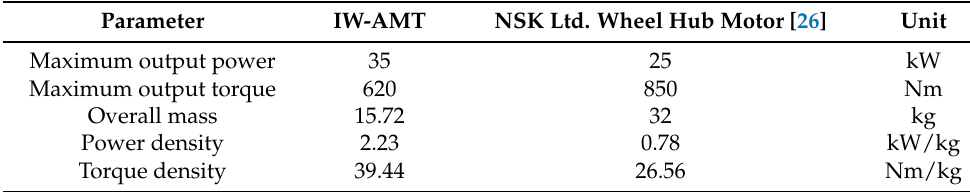
Table 2. Comparison of the main technical parameters.